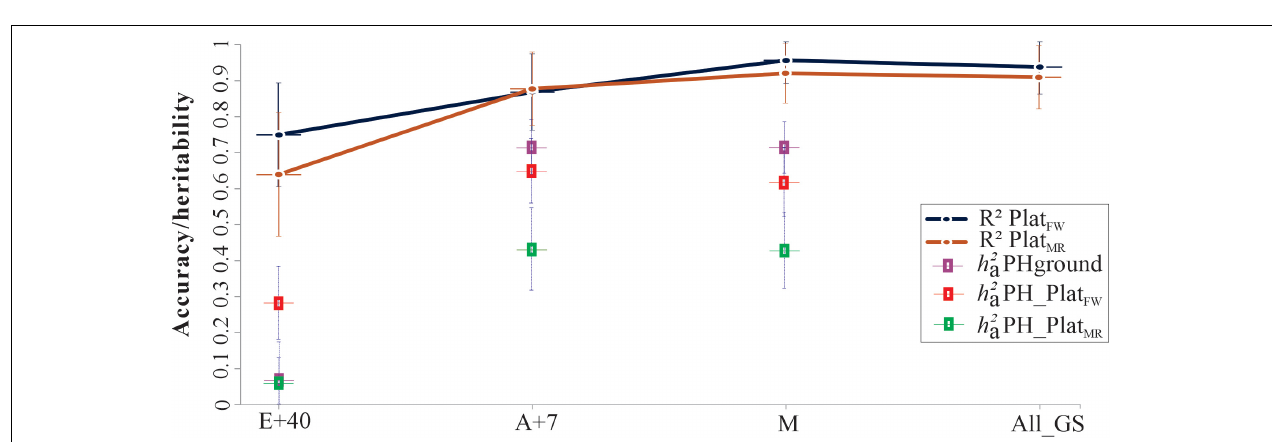
FIGURE 7 | The solid color lines represent the broad-sense heritability ( H 2 g ) across crop cycles (2016–2017 and 2017–2018) for Plat FW , Plat MR and PHground in the growth stages: 40 days after emergence (E+40), booting (B), 7 days after flowering (A+7), and at physiological maturity (M) and its 95% confidence interval based on standard errors. The color bars show the Spearman Rank Correlation ( ρ ) from the predicted values between PHground and PHaerial. All ρ significant at P < 0.0001 except to B (non-significant) in HiBAP-II Y18.